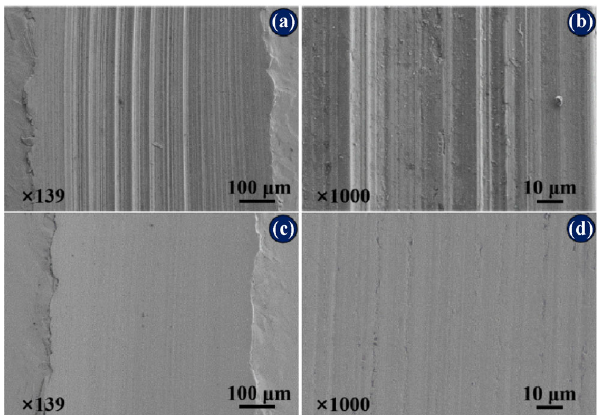
Fig. 12 SEM micrographs of worn disk surfaces under (a, b) the MF and (c, d) MIL lubrication under 100 N and 150 °